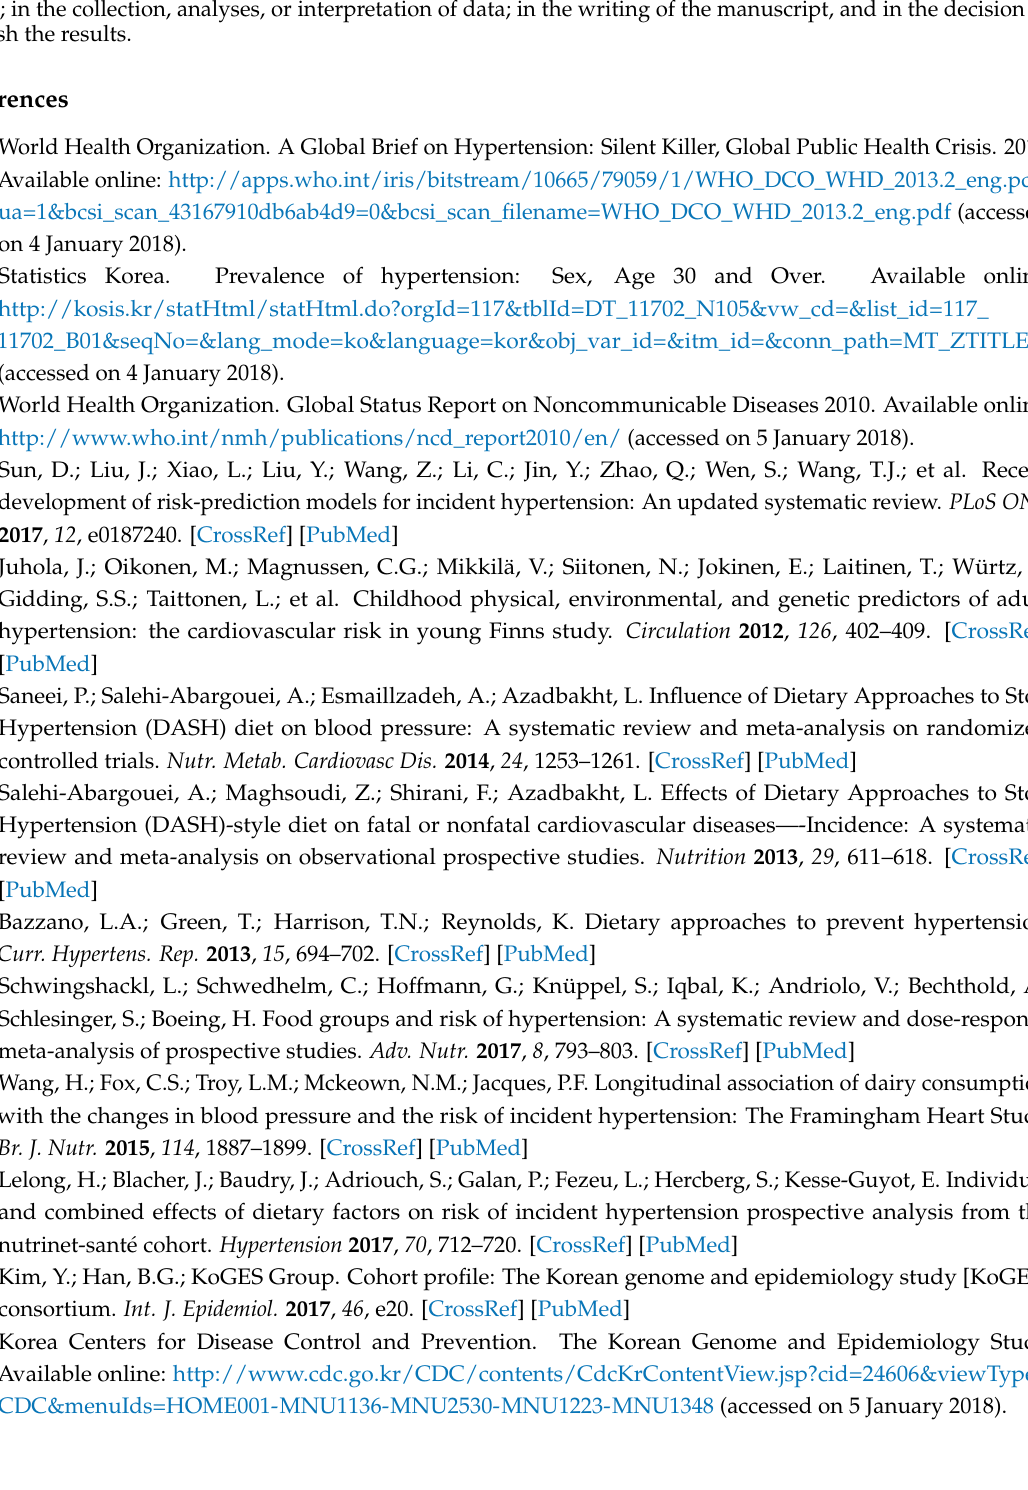
Table S1: Composition of the 20 food groups; Table S2: Criteria for subgrouping of daily intake (g/day) of the 20 food groups; Table S3: Average daily intakes (g) of the 20 food